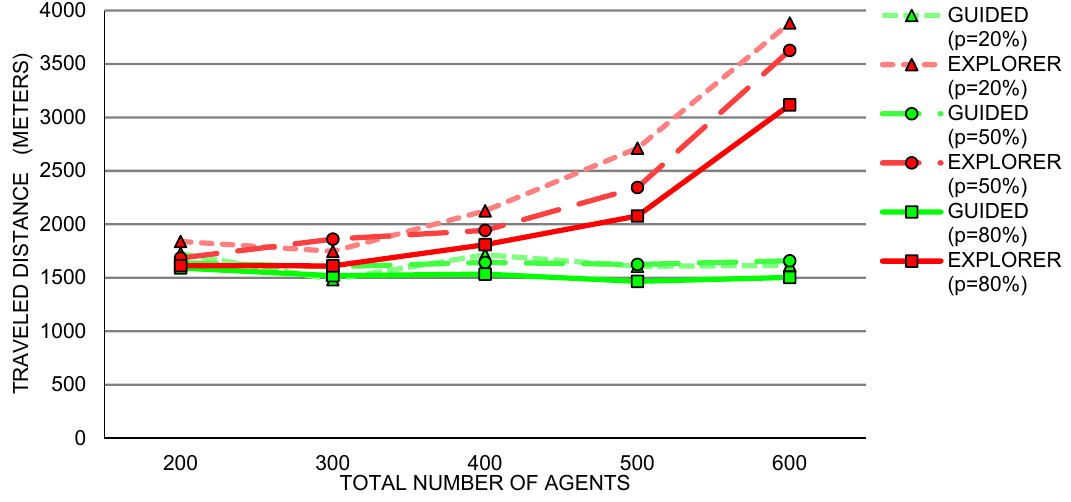
Figure 9. Traveled distance when considering only one campus